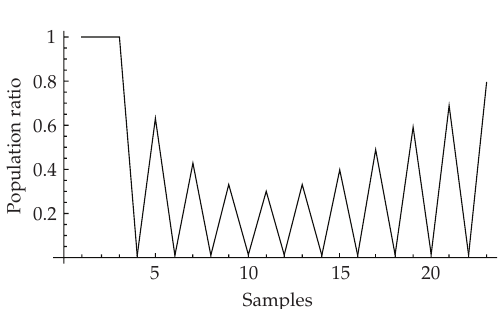
Figure 4: Relative comparison with the standard Beverton-Holt equation.